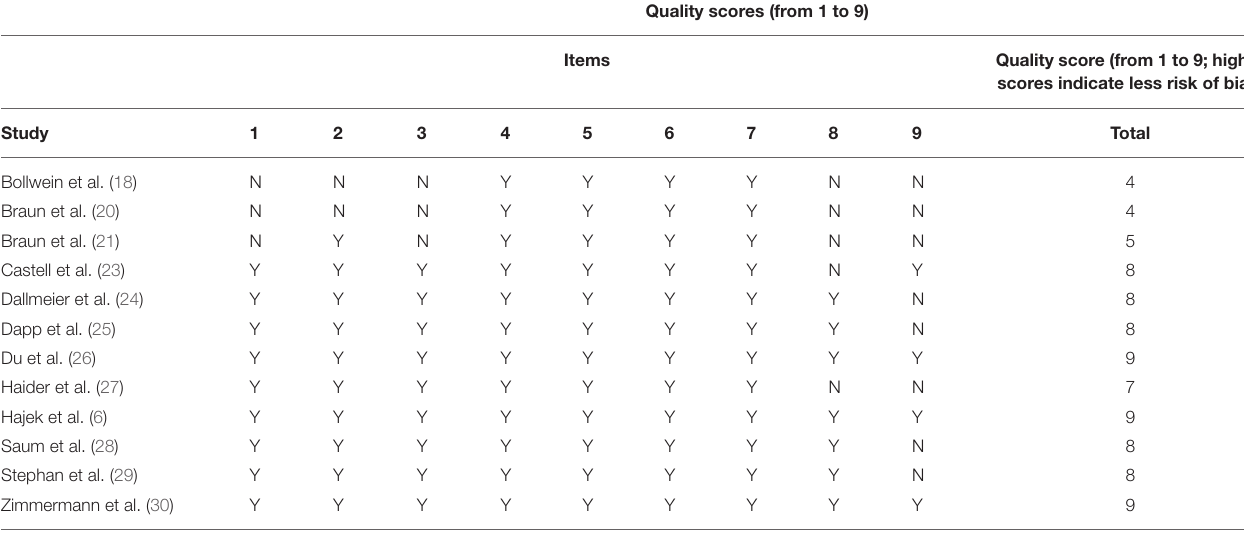
TABLE 4 | Quality assessment/risk of bias assessment.